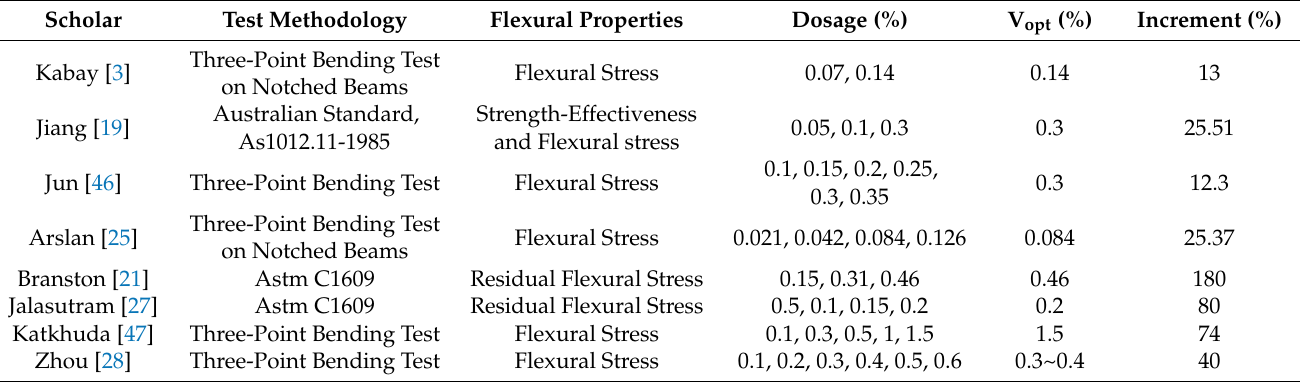
Table 1. Research status of the optimal dosage of basalt fiber for flexural